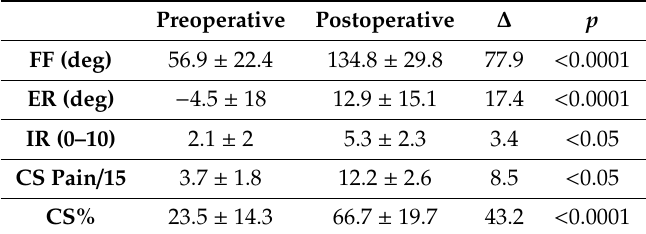
Table 2. Clinical